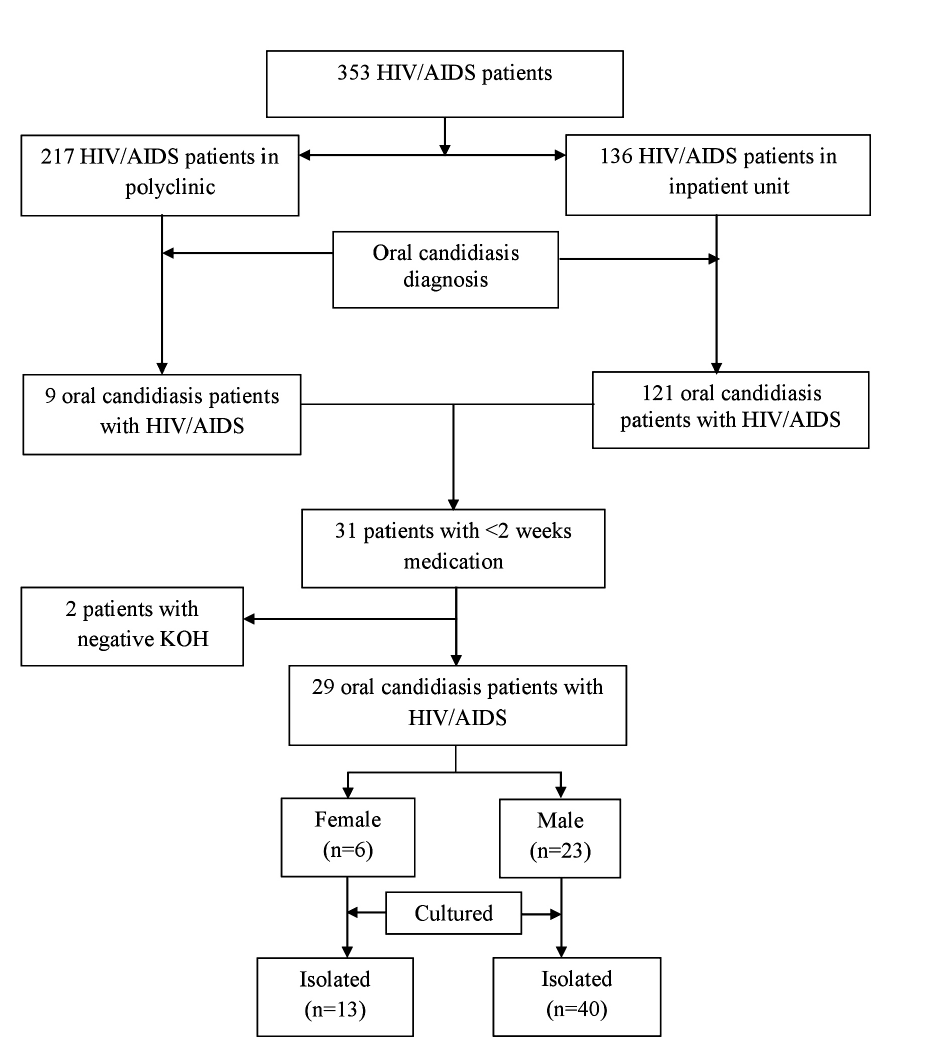
Fig. 1. Flowchart Diagram of Subject Sampling